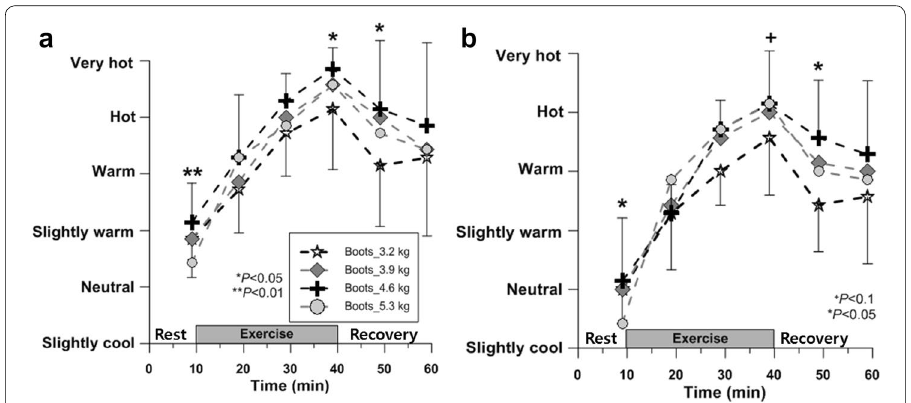
Fig. 4 Time courses of overall thermal sensation ( a ) and feet thermal sensation ( b ). * P < 0.05, ** P < 0.01, and *** P < 0.001